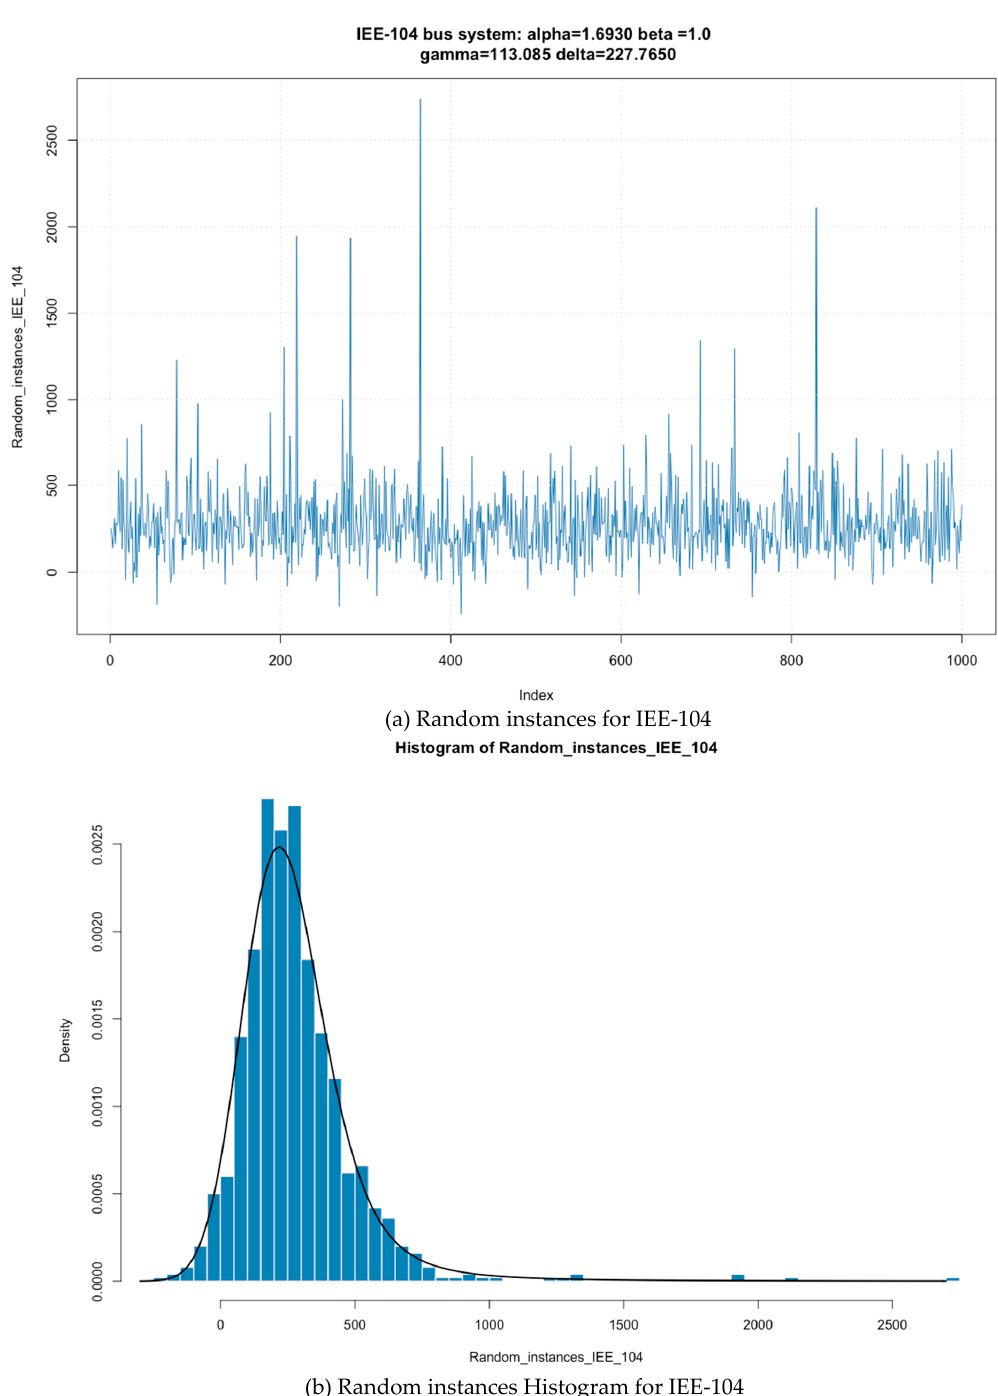
Figure 2. IEEE-104 bus system simulations.